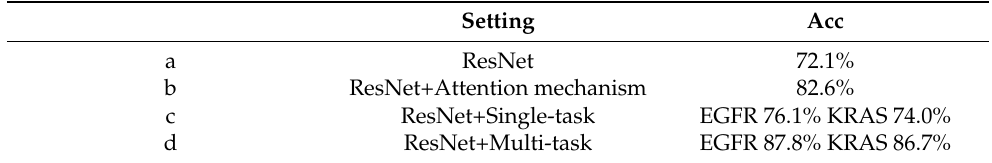
Table 2. Results of different combinations of ablation experiments.